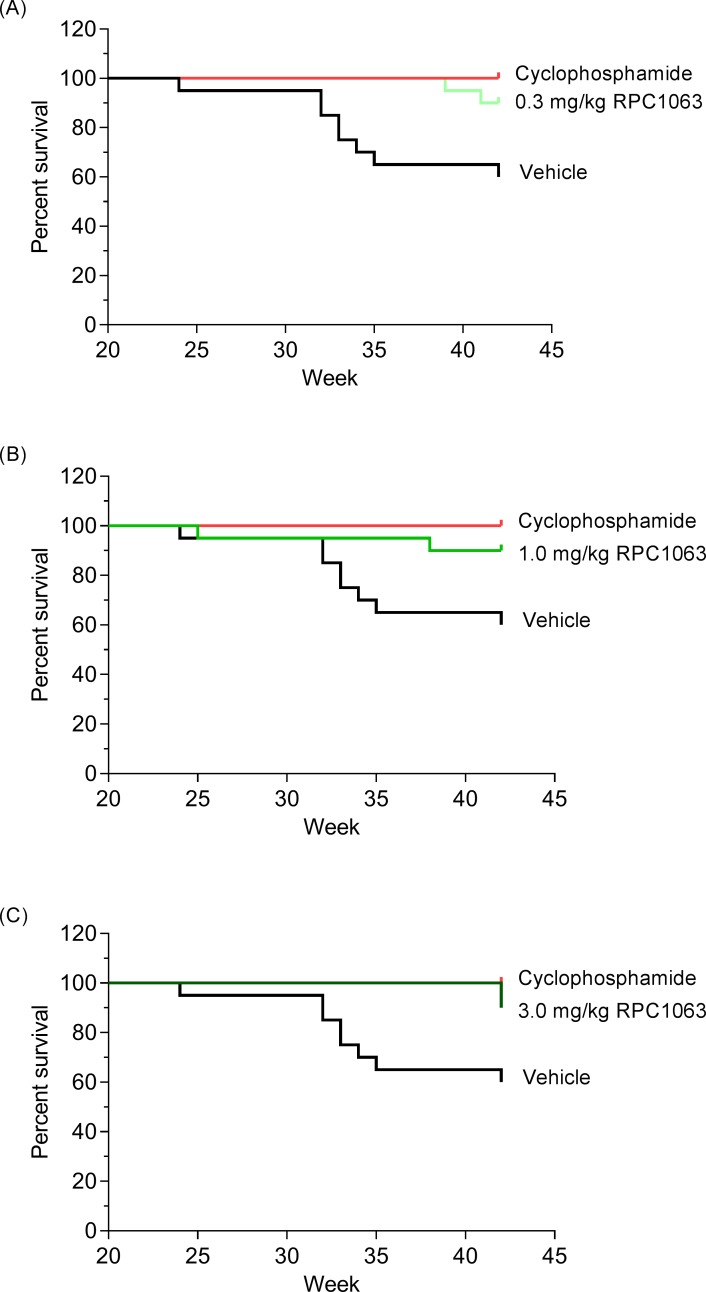
Percent survival of NZBWF1 mice over the 42-Week study.Treatment was started for all groups at week 23. Mice treated with vehicle (black line), cyclophosphamide (red line), and (A) 0.3 mg/kg RPC1063, (B) 1.0 mg/kg RPC1063, and (C) 3.0 mg/kg RPC1063 (green lines).